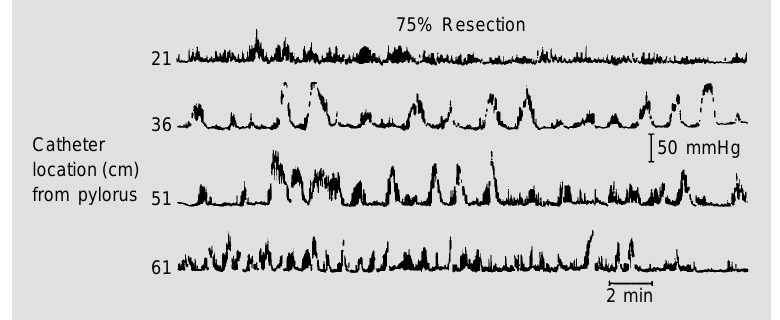
Figure 7 - The motor response to an extensive intestinal resection. Recordings of motor activity from the intestinal remnant in an animal following resection of the distal 75% small intestine. Note the dominance of intense “cluster” activity throughout the intestinal rem-